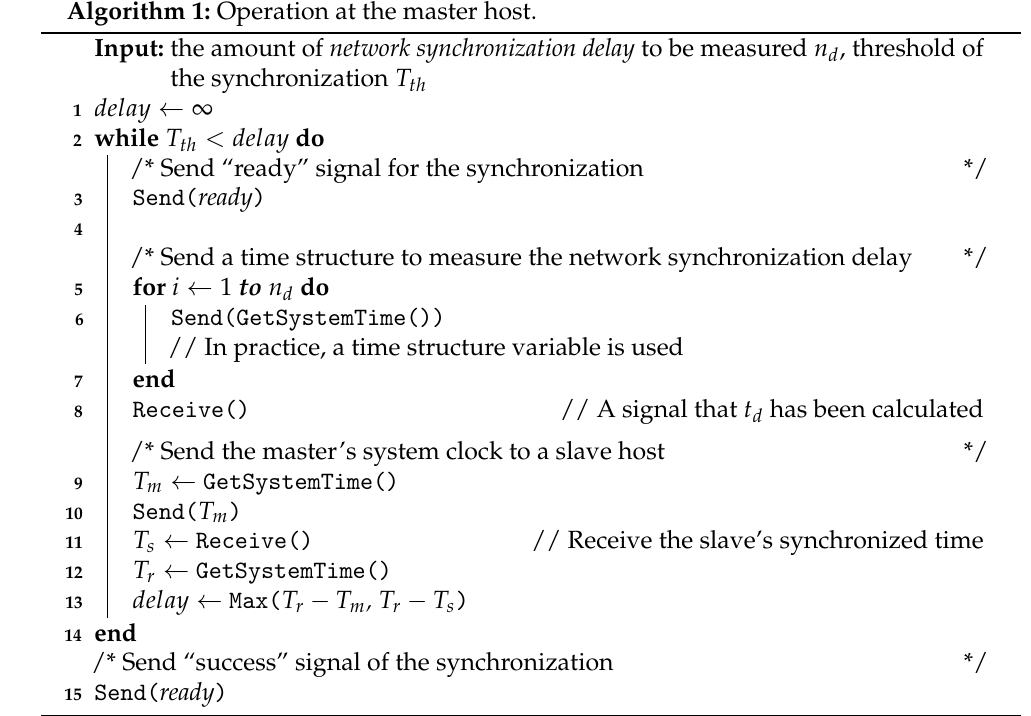
Algorithm 1: Operation at the master